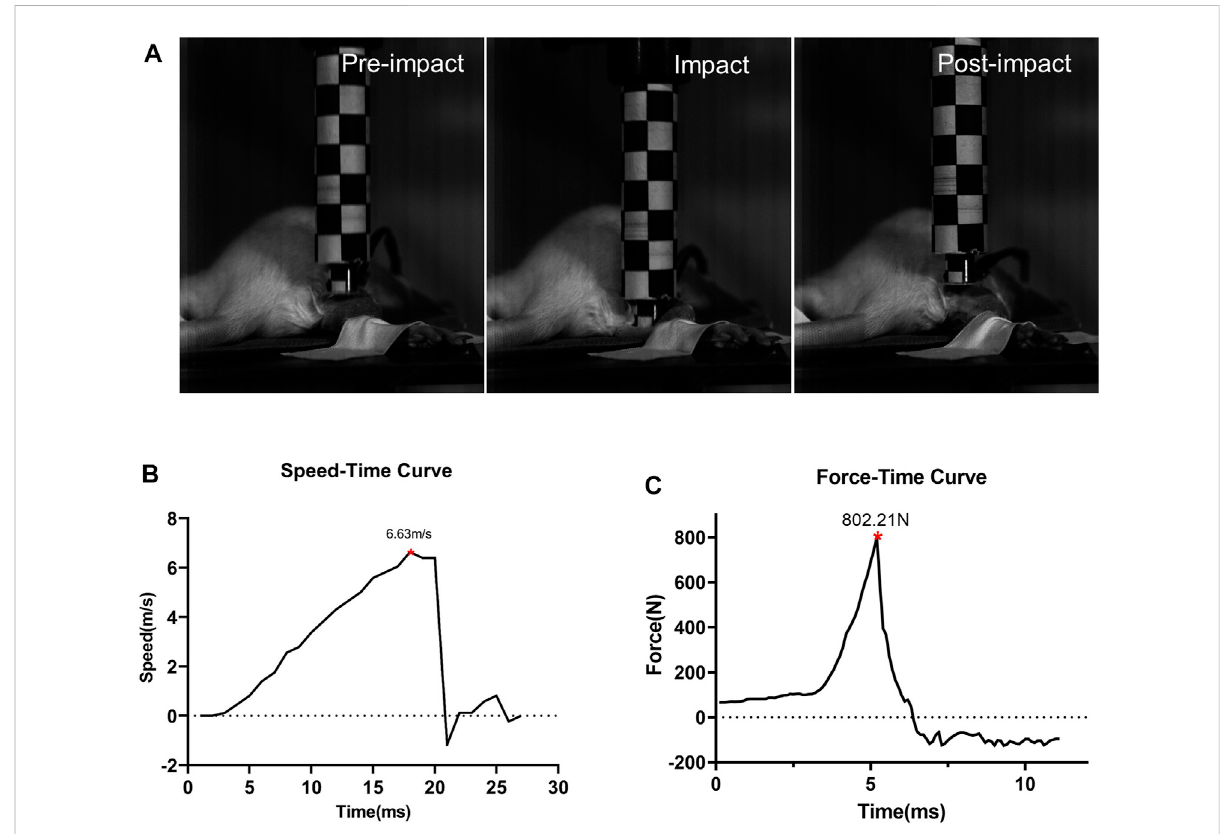
FIGURE 3 Impactprocessand impact-relatedparameters ( n =5). (A) Impactprocess. Detailsbefore, during,and after theimpact. (B) Speed-time curveof the impactor. (C) Force curves detected by the sensor during